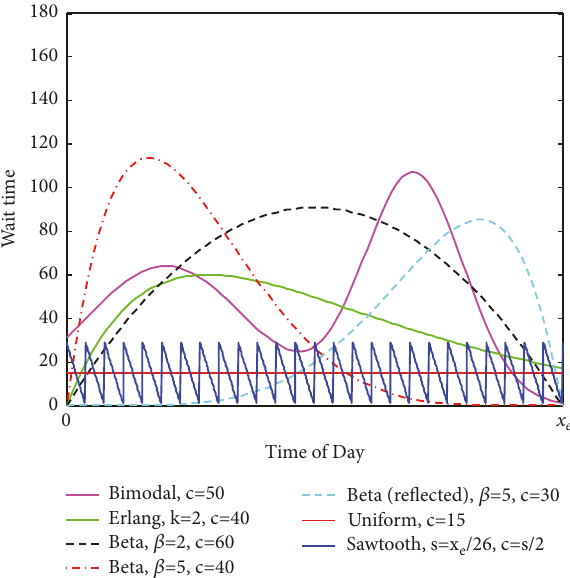
Figure 7: Examples of distributions used to generate wait times for test